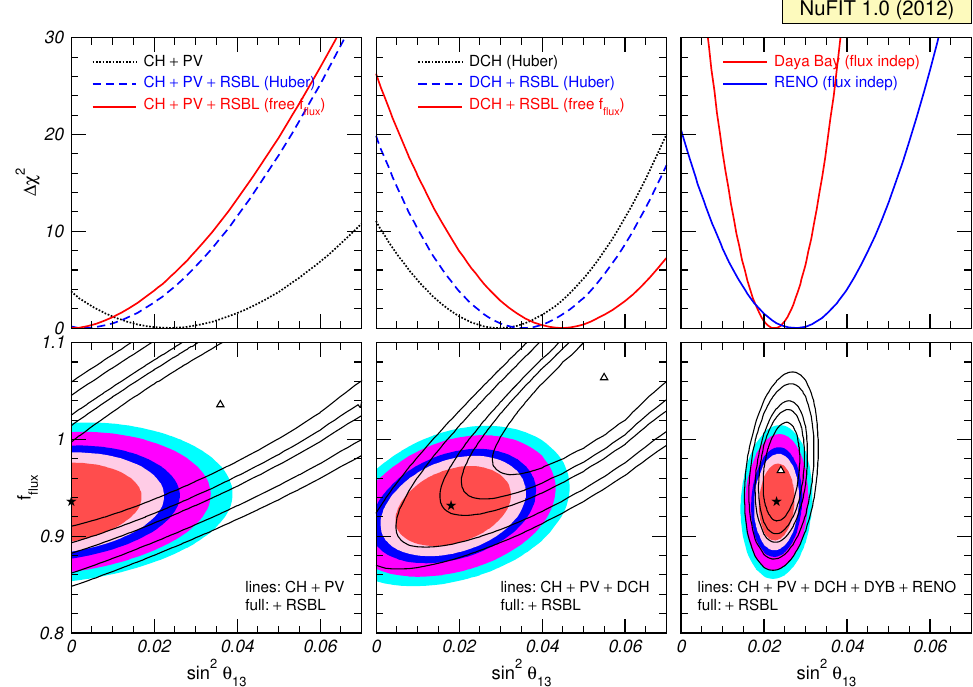
Figure 2. Dependence on reactor flux normalisation choice in NuFIT 1.0. ( upper ) Dependence of ∆ χ 2 = 2.47 × 10 − 3 eV 2 ) for the set of reactor experiments included in the on sin 2 θ 13 (for fix value ∆ m 2 31 analysis and three different assumptions on the fluxes as labeled in the figure. ( lower ) Confidence level contours in the plane of sin 2 θ 13 and flux normalisation f flux . Full regions and lines correspond to analysis with and without including the RSBL experiments, respectively. Figure adapted from